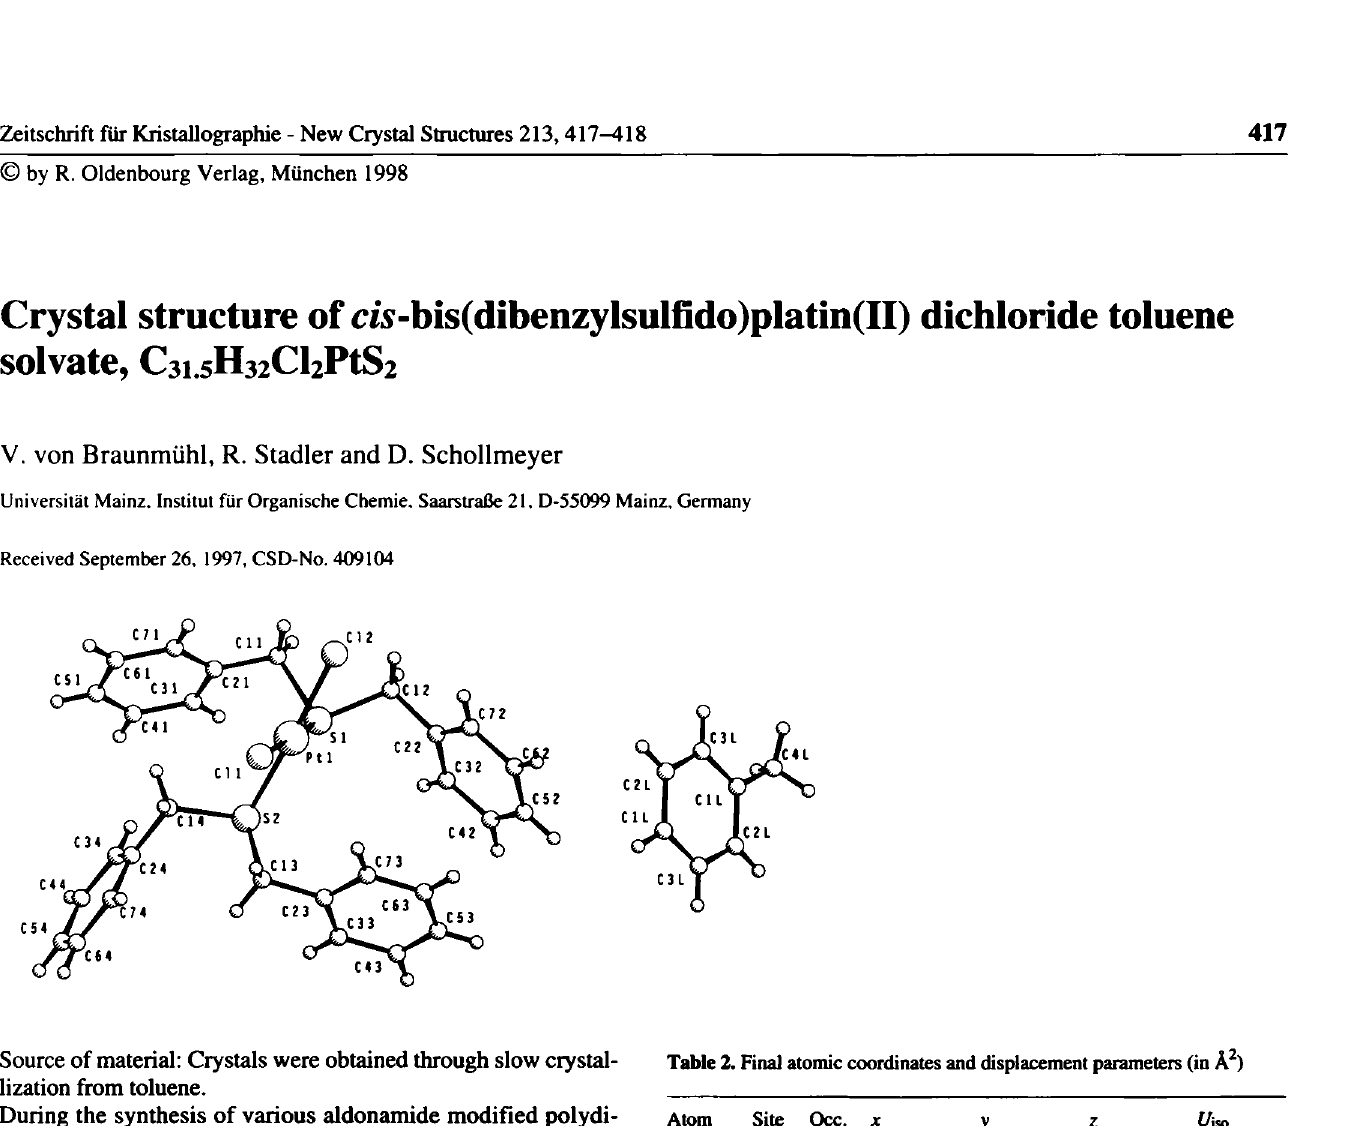
Table 1. Parameters used for the X-ray data collection